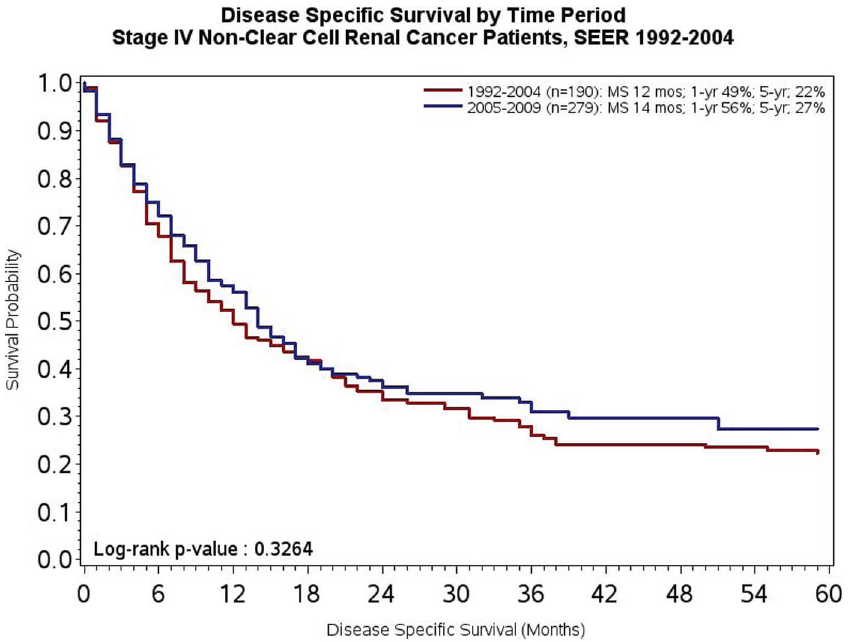
Figure 3. DSS of patients with denovo mRCC diagnosed from 1992 – 2004 as compared to 2005 – 2009 with non-clear cell (i.e., papillary or chromophobe)